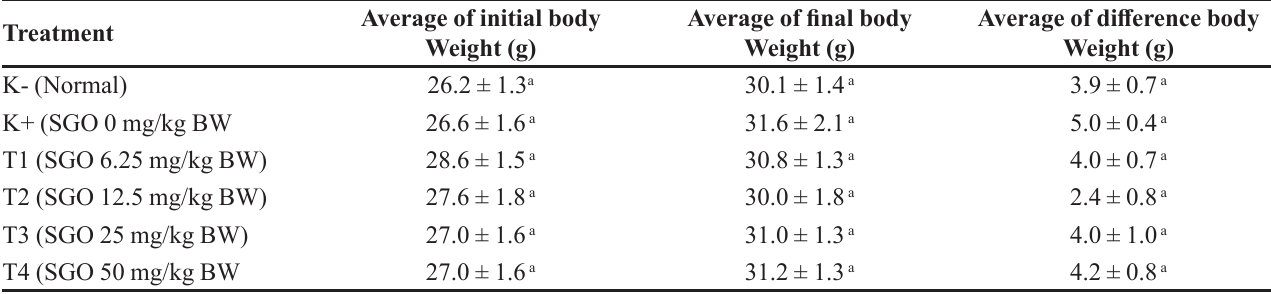
TABLE I - The average of mice body weight (initial, final, and difference) Treatment